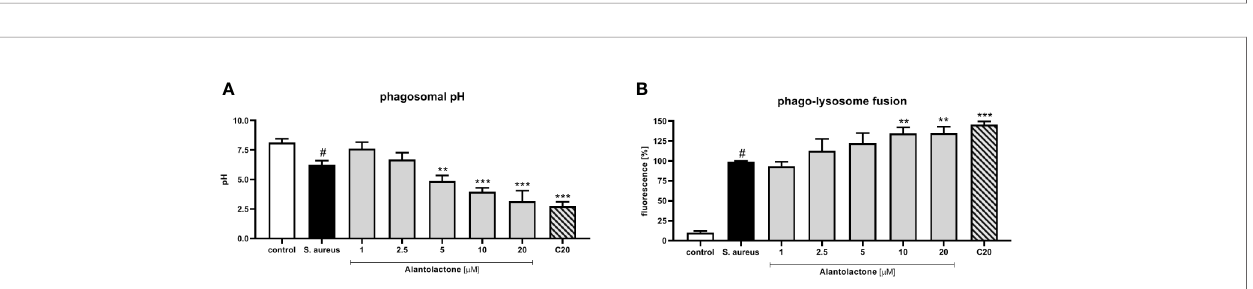
FIGURE 4 | The infection of THP-1 cells by S. aureus . Data show photographed controls (not infected cells) and S. aureus infected cells (15 min after infection). The blue marker — DAPI-labelled nucleus, the pink marker — Alexa 647 labelled- S. aureus .